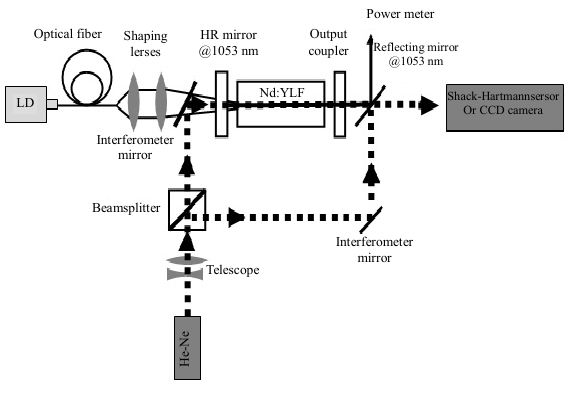
Fig. 6 Experimental setup, the dashed lines represents the He-Ne laser beams and solid lines for laser at 1053 nm.